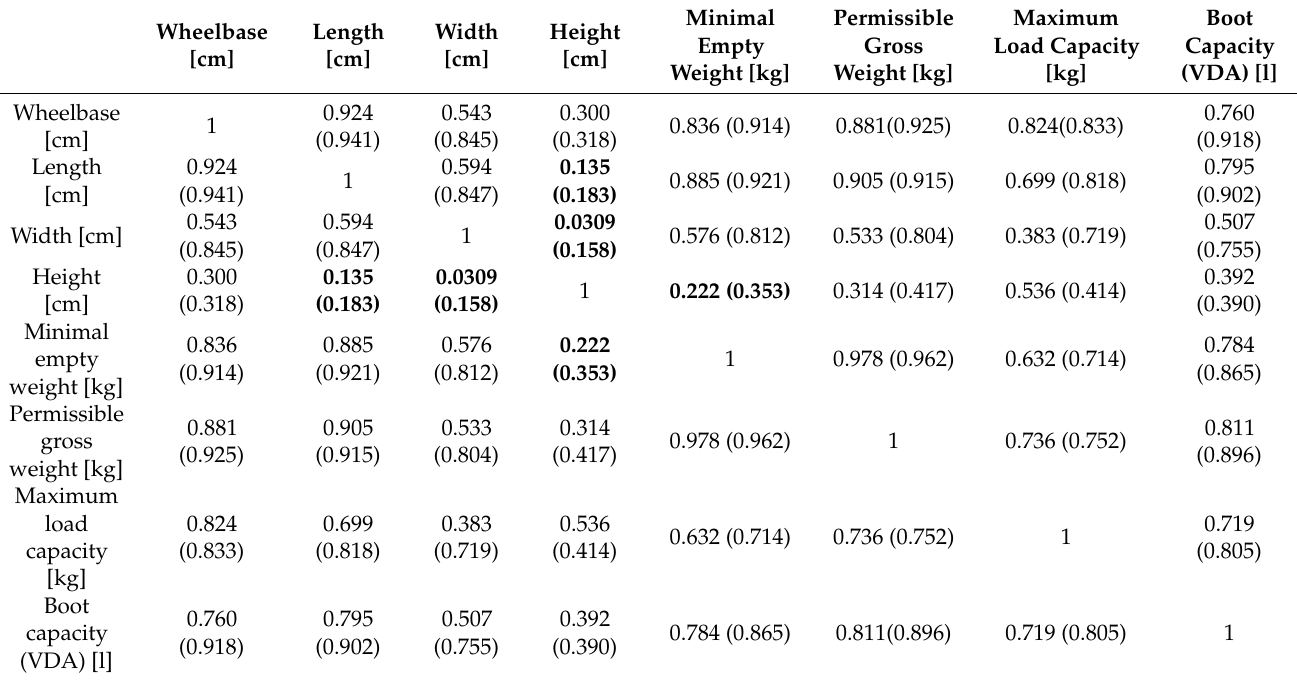
Table 5. The values of the correlation coefficients in size group.